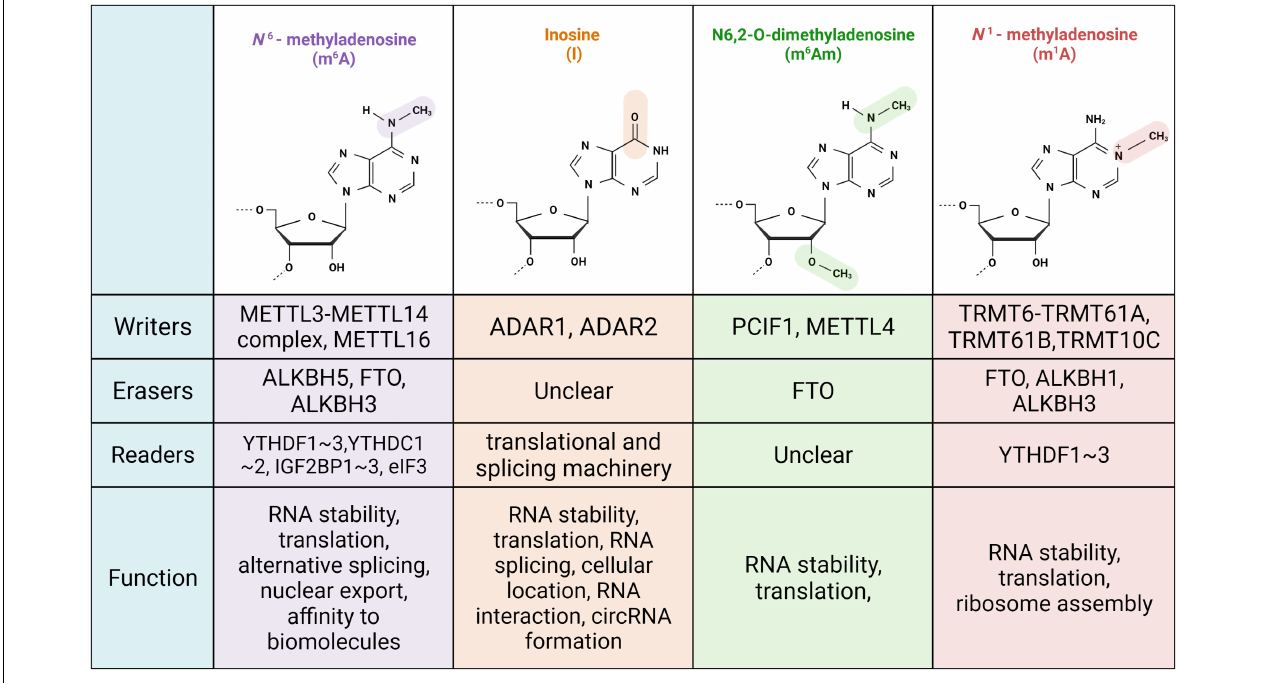
FIGURE 1 | Schematic diagram of chemical formula, relative proteins and physiology function of common RNA